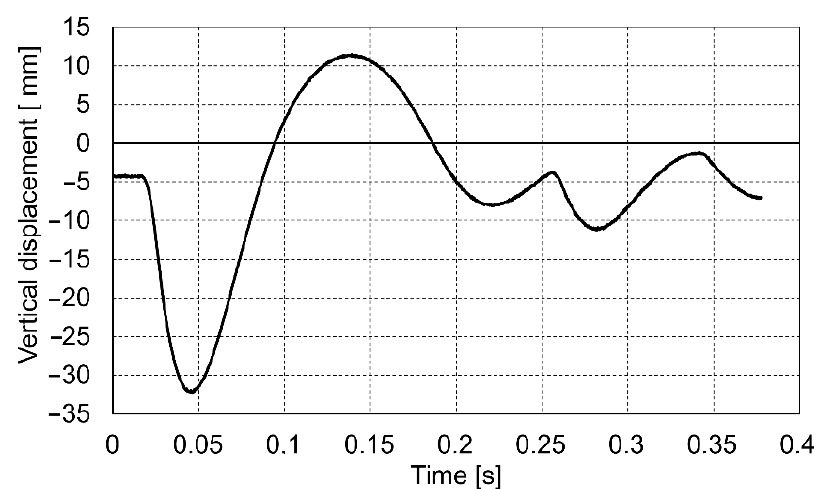
Figure 10. Vertical displacement of the p0 point during drop No. 2.